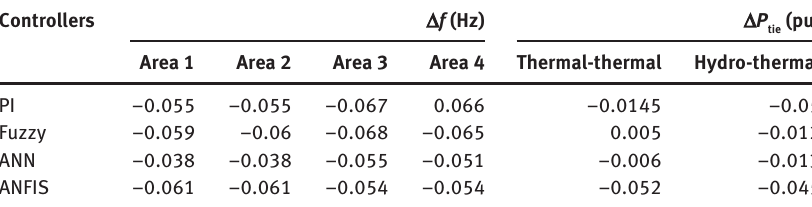
Table 3. Comparative Study of Peak